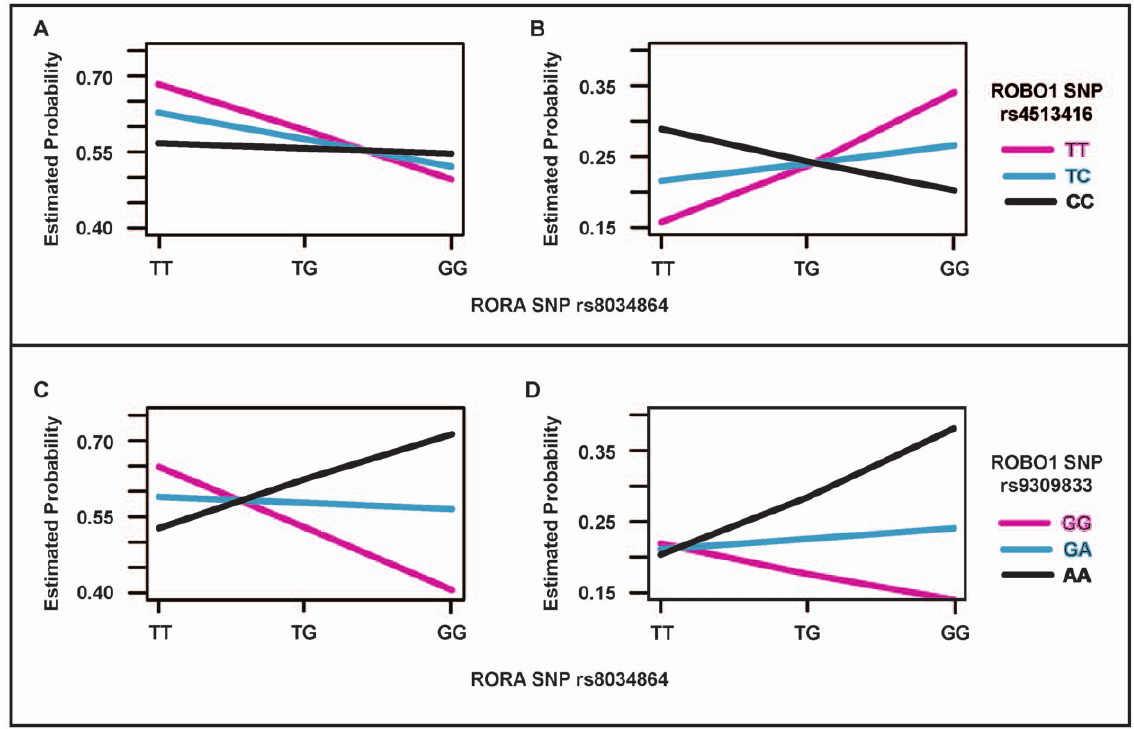
Figure 1. Estimated probabilities for different categories of genotypes between ROBO1 SNPs and a RORA SNP in meta-analysis. X- axis is the categories of genotypes for rs8034864 from the RORA gene, and Y-axis is the estimated probabilities of different genotypic groups for rs4513416 (A and B) and rs9309833 (B and C) from the ROBO1 gene after adjusting for covariates. Graphs for wet AMD are shown in A and C, and for dry AMD in B and D.